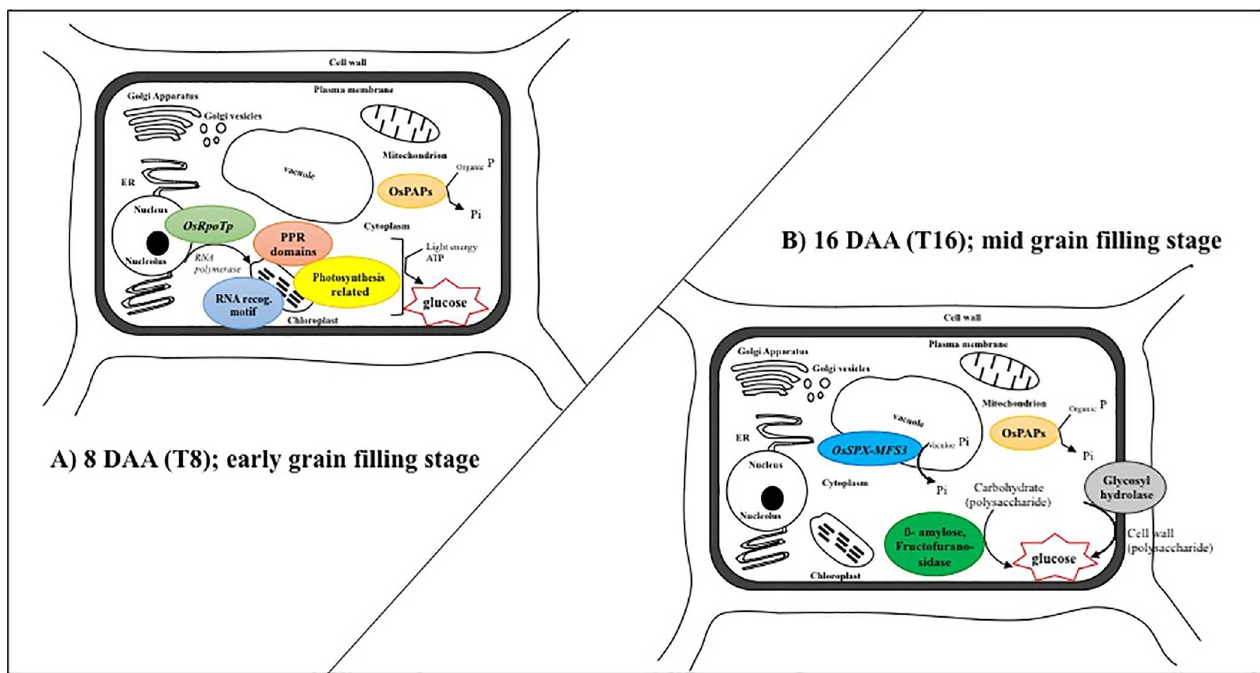
Fig 5. Hypothesised response to P withdrawal at the cellular level during grain filling (A) at 8 DAA and (B) 16 DAA based on differentially expressed genes.